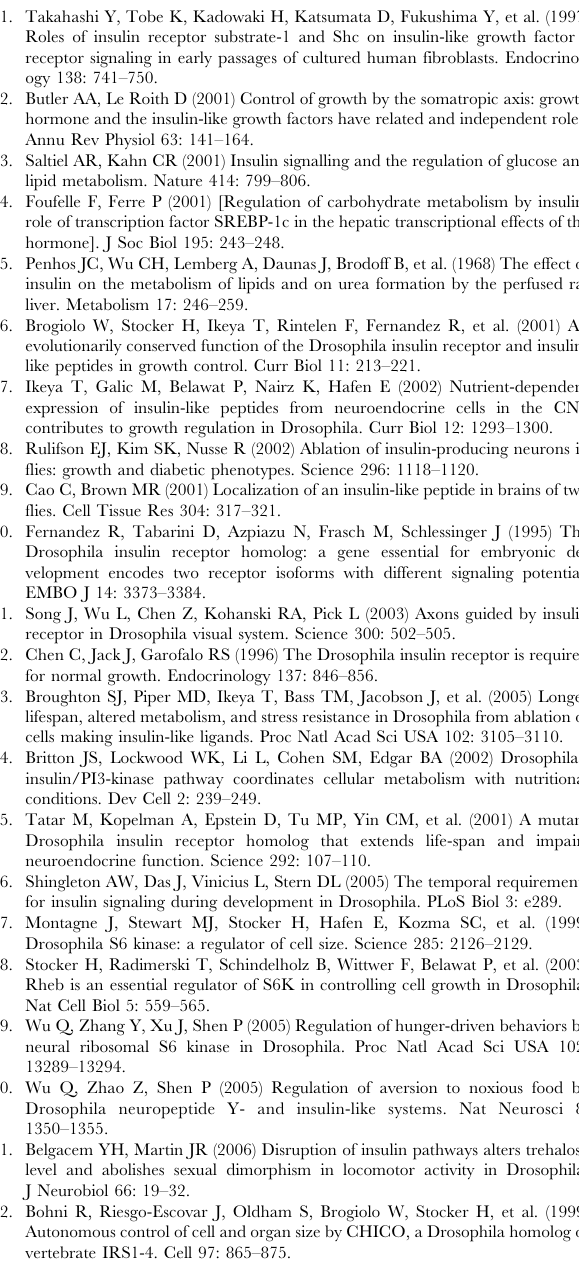
Figure S1 Targeted expression of a dominant negative form of SREBP in the corpus allatum abolishes the sexual dimorphism. Expressing p[UAS- srebp DN ] in the ca under the control of DI-11 abolishes the sexual dimorphism (b) comparing to appropriated controls p[UAS- srebp DN ]/CS